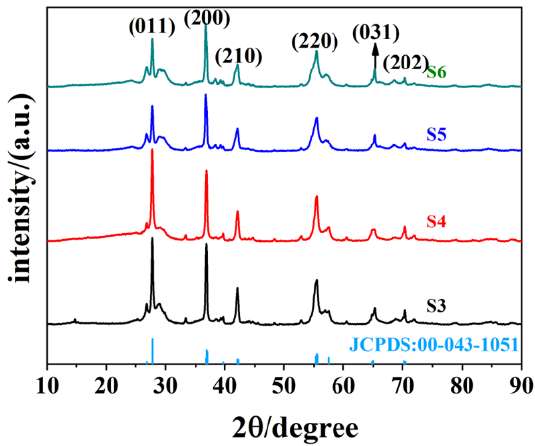
Figure 2. XRD data for the hydrothermal product with different molar ratios between and V 2 O 5 , and ratios for S3–S6 are 1.5:1, 2:1, 2.5:1, and 3:1, respectively.